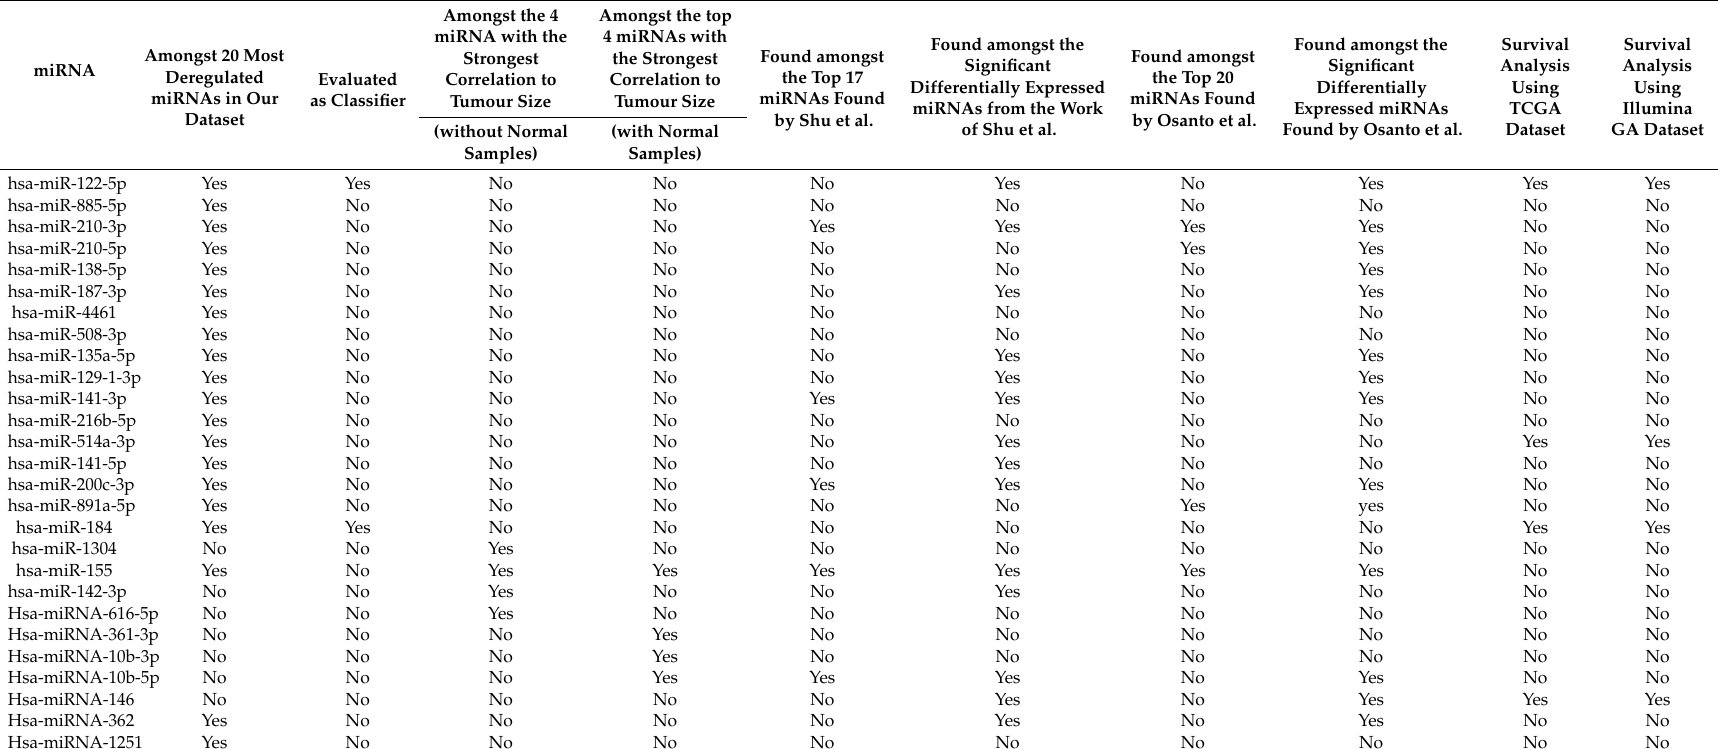
Table A2. Overview over which miRNAs were found to be most significant in which